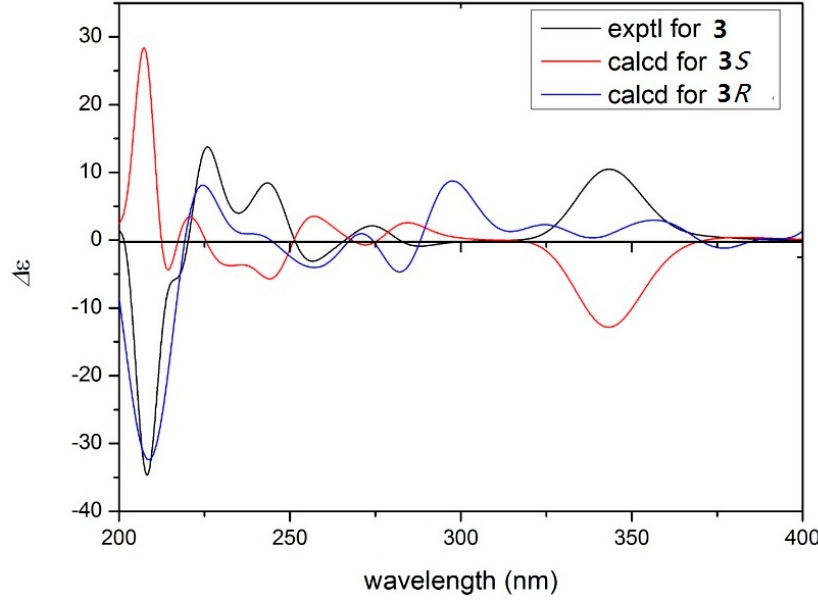
Figure 3. Calculated and experimental circular dichroism (CD) spectra of compound 3 .